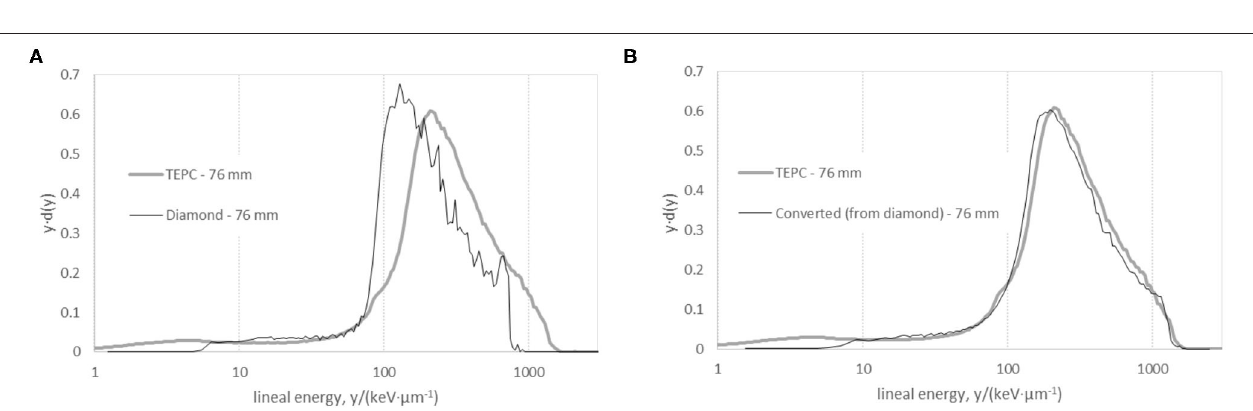
FIGURE 13 | Microdosimetric spectra of Italian National Center for Oncological Hadrontherapy (CNAO) 195 MeV/u carbon ion clinical beam at a water-equivalent depth of 76mm. (A) Spectra collected with the cylindrical propane-based mini-tissue-equivalent proportional counter (TEPC) (gray thick line) and with the diamond microdosimeter (black thin line). (B) The diamond spectrum was recalculated to represent the response of the cylindrical propane-based mini-TEPC. TEPC data from Colautti et al. [8] and diamond data from Magrin et al. [31].